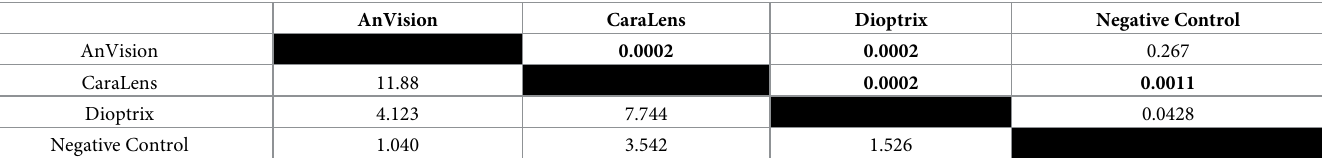
Table 3. Pairwise comparisons by brand using Jaccard similarities.